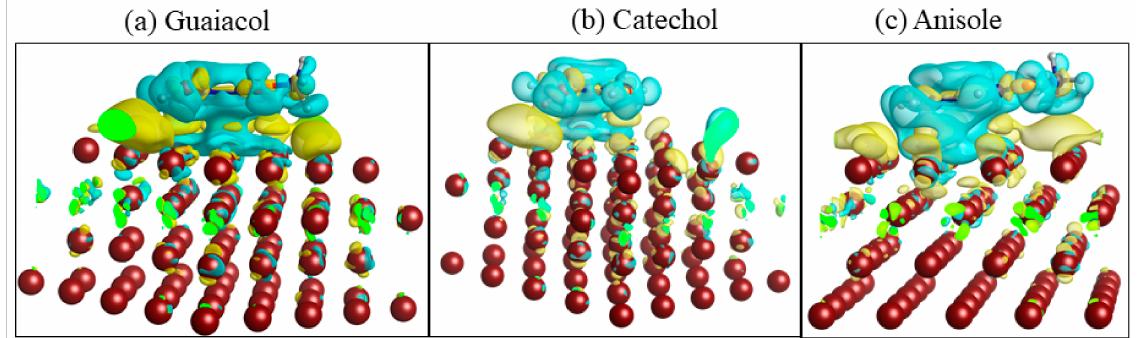
Figure 5. Charge density difference plots between the Cu (111) surface and the molecules; ( a ) guaiacol ( b ) catechol and ( c ) anisole. Colour code: yellow regions indicate electron depletion (holes) and cyan regions show electron accretion